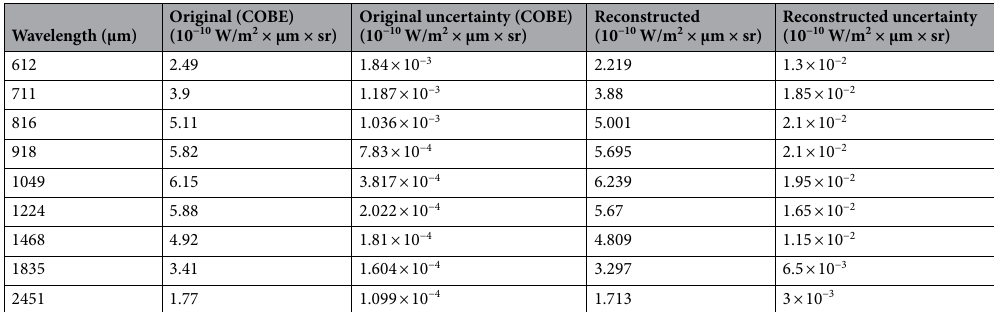
Table 3. The values of original and reconstructed data for intensity are listed. The original and reconstructed spectrum uncertainties are also included.